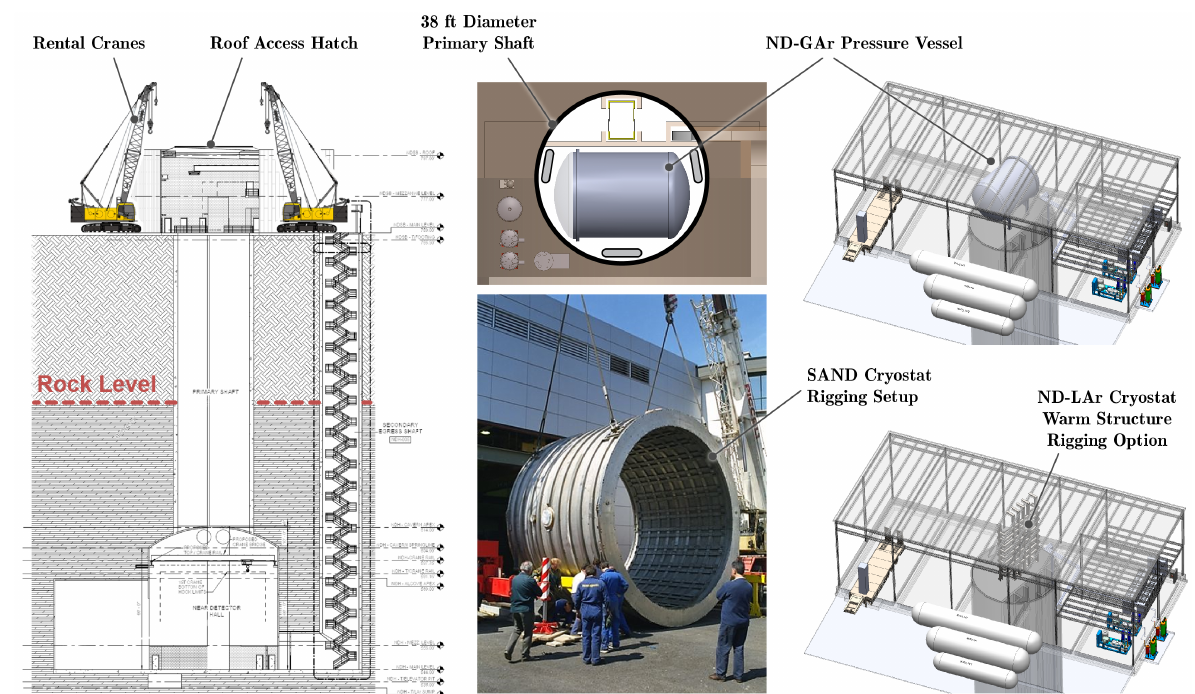
Figure 181. A roof hatch in the surface building and above the shaft will be utilized to lower large and heavy detector components underground utilizing rental cranes. The primary shaft diameter is large enough for the ND-GAr pressure vessel or the SAND solenoid cryostat. Such a shaft size would permit rigging fully welded ND-LAr cryostat warm structure panels underground which could significantly ease underground installation.